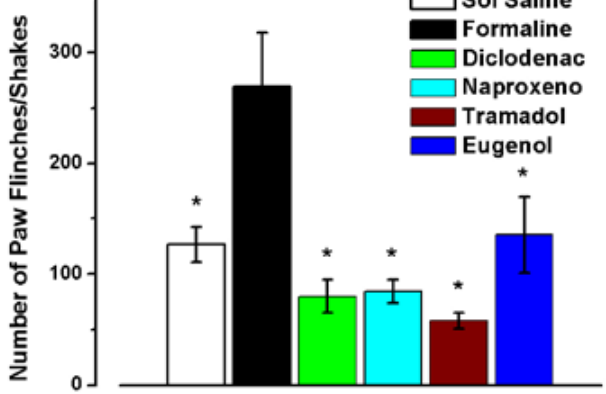
FIGURE 3 - Graphic of the phase 2 formalin test, the data representing the Ẋ ± SEM of an n = 5; *P ≤0.05 vs. the 5% formalin